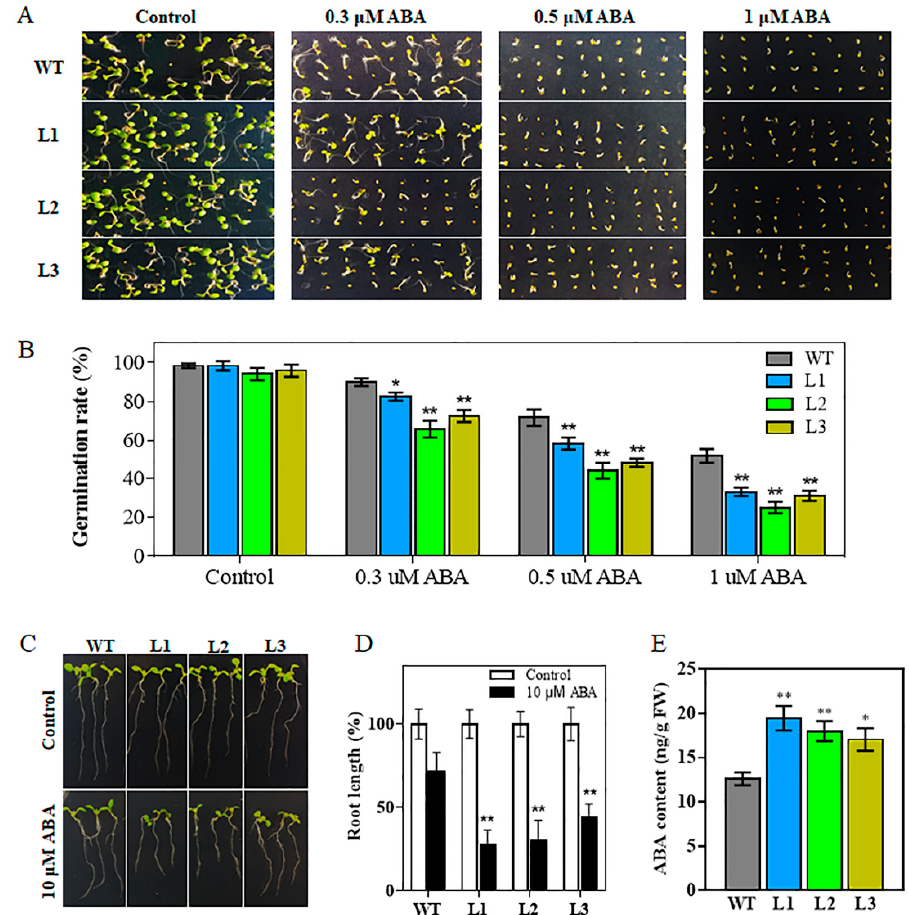
Figure 6. E ff ect of ABA on TaHsfA6f transgenic Arabidopsis plants. ( A – B ) Germination assays of TaHsfA6f transgenic plants under ABA treatment. Seed germination ratios of WT and three TaHsfA6f transgenic lines on 1 / 2MS agar media with di ff erent concentrations of ABA. ( C ) Morphology of WT and three TaHsfA6f transgenic seedlings grown vertically on 1 / 2MS agar media with or without 10- µ M ABA. The photographs were taken three days after seedlings were transferred to the indicated agar media. ( D ) Root length recorded before photographing. ( E ) Levels of endogenous ABA in the leaves of WT and the three transgenic lines under normal conditions. Data shown are means ± SD of three independent experiments ( * p < 0.05, ** p < 0.01 by Student’s t